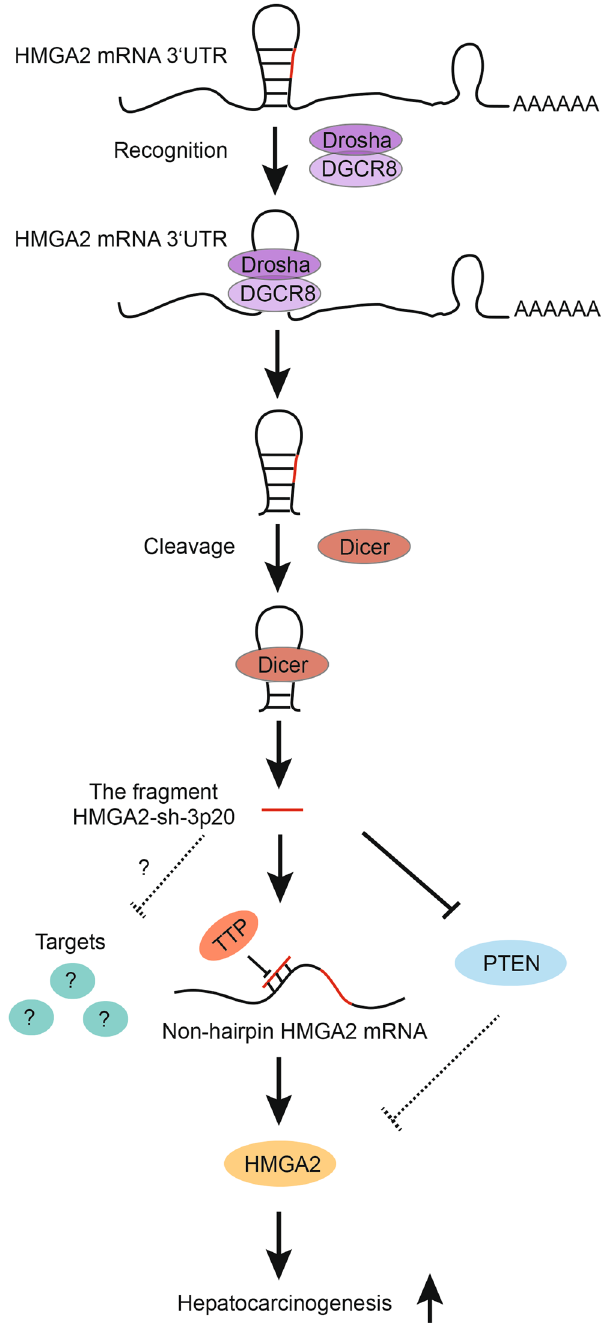
Figure 7. A model shows that the fragment HMGA2-sh-3p20 from HMGA2 mRNA 3 ′ UTR promotes the growth of hepatoma cells by upregulating HMGA2. Bioinformatics analysis shows that 3 ′ UTR of HMGA2 mRNA contains the hairpin structure (HMGA2-sh). Drosha and DGCR8 cleave the HMGA2-sh from the 3 ′ UTR of HMGA2 mRNA, and Dicer contributes to the generation of the HMGA2-sh-3p20 from the HMGA2-sh. Furthermore, HMGA2-sh-3p20 is able to increase the levels of HMGA2 by antagonizing TTP- mediated HMGA2 degradation, while it decreases PTEN by targeting 3 ′ UTR of PTEN mRNA. In addition, the downregulated-PTEN is not able to depress the expression of HMGA2, leading to the upregulation of HMGA2. Functionally, HMGA2-sh-3p20-enhanced HMGA2 accelerates the growth of liver cancer